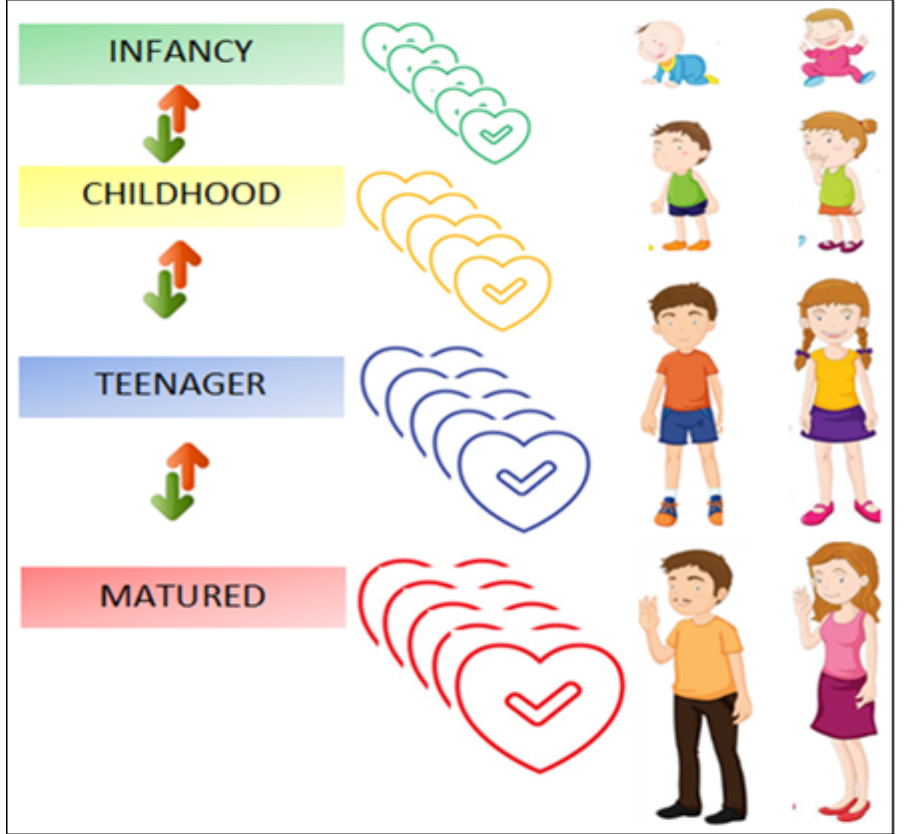
Figure 1. Game mechanics of Ethoshunt. The green arrow indicates advancement to the next level, and the red arrow indicates demotion to the previous